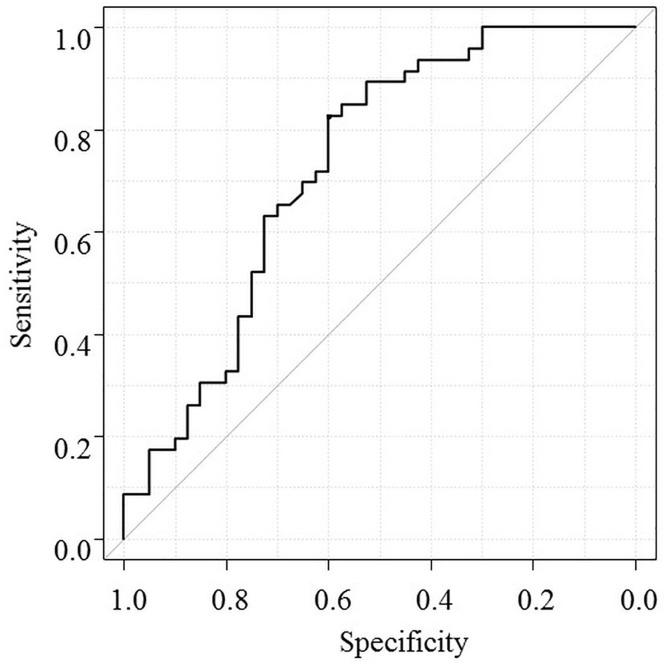
ROC curve analysis of spot urine Na/K ratio and prediction of weight loss.The ROC curve shows baseline spot urine Na/K ratio to predict weight reduction ≥2% on day 7 of tolvaptan therapy. Urine Na/K ratio ≥2.5 was the best cutoff value to predict effectiveness.